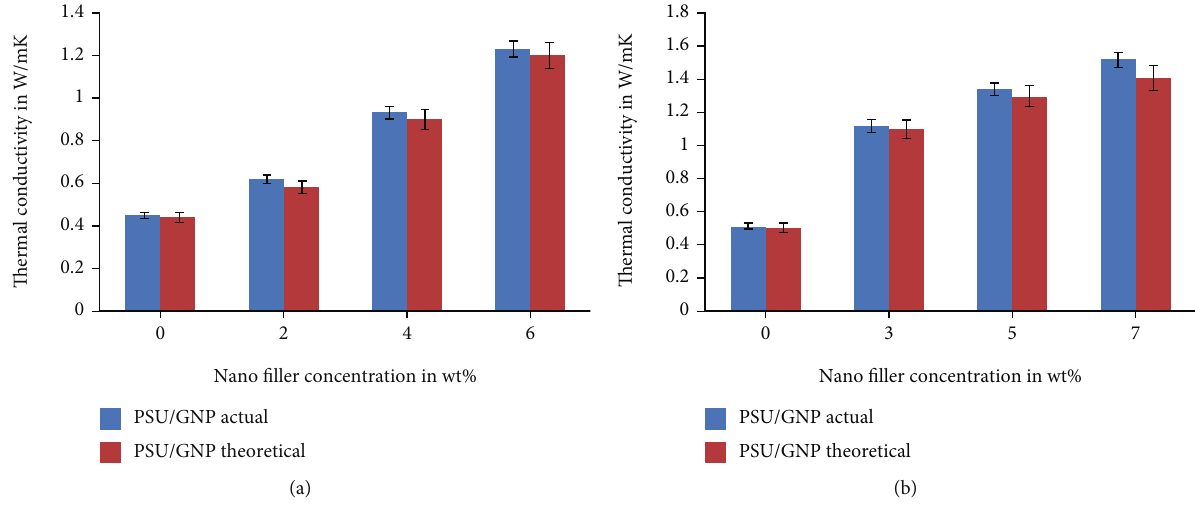
Figure 3: (a) E ff ect of GNP nano fi ller concentration on thermal conductivity of PSU composite compared with the theoretical value. (b) E ff ect of CNT nano fi ller concentration on thermal conductivity of PSU composite compared with the theoretical value.